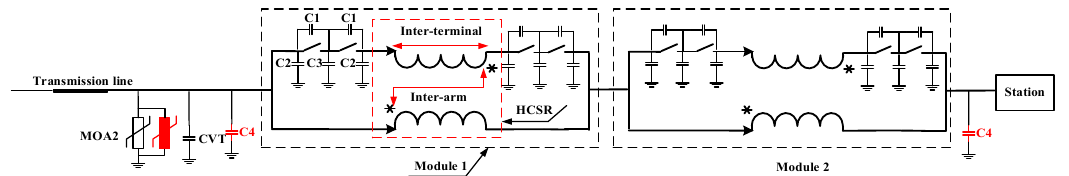
Figure 10. The topology of the HCSR-FCL with the first protection measures.